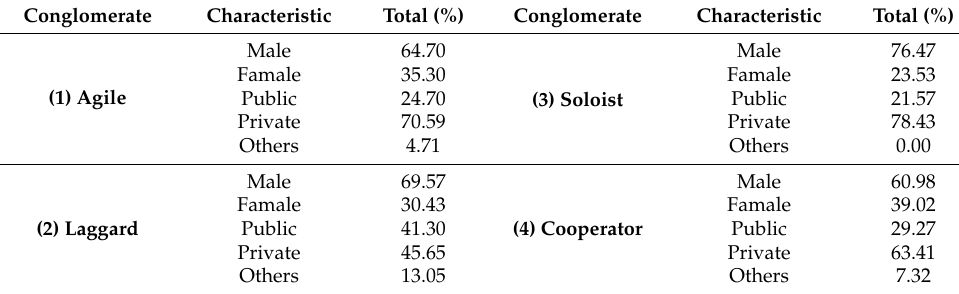
Table 4. Description of obtained